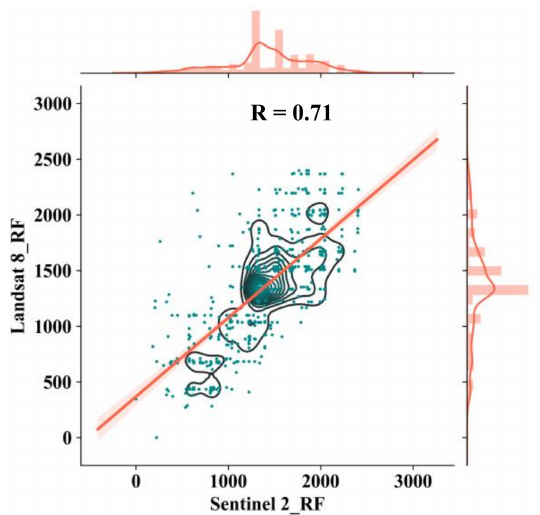
Figure 12. Scatter plot of Landsat 8 and Sentinel 2 inversion